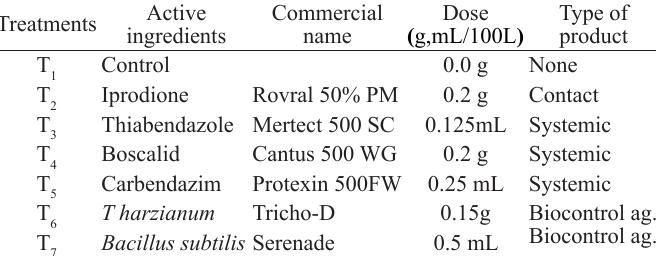
Table 1 : In vitro treatments for the Sclerotium cepivorum